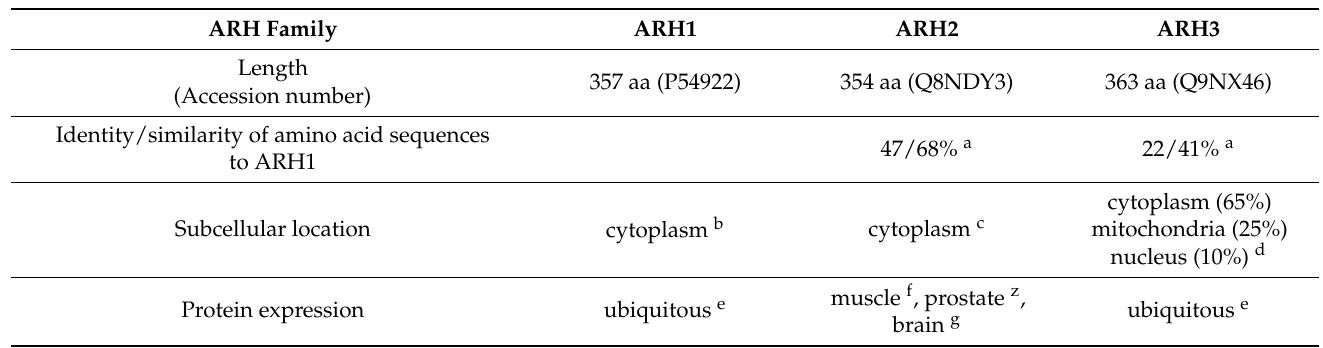
Figure 4. Schematic diagram of substrates of ARH1 and ARH3. Arrow indicates linkage cleaved by ARH1 and ARH3. ARH1 and/or ARH3 catalyze stereospecific hydrolysis at α -ADP-ribosyl-arginine (ARH1) [72,73], α -ADP-ribosyl-serine (ARH3) [23,24], poly(ADP-ribose) (ARH3) [59], O -acetyl-ADP-ribose (ARH1 and ARH3) [70,82], and α -NAD + (ARH1 and ARH3) [76]. ChemDraw from PerkinElmer informatics was used to draw the diagram. Table 1. ADP-ribose-acceptor hydrolase family.